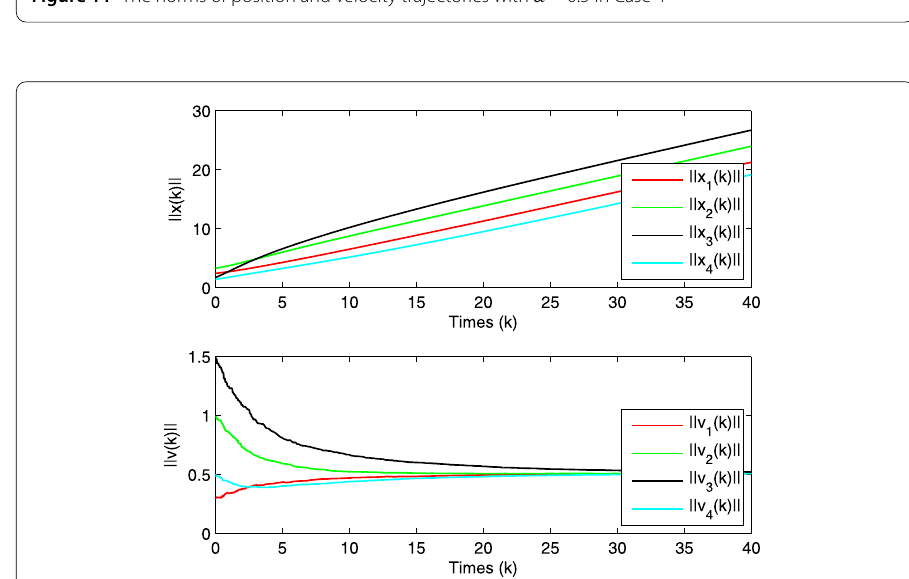
Figure 12 The norms of position and velocity trajectories with α = 1 in Case 4